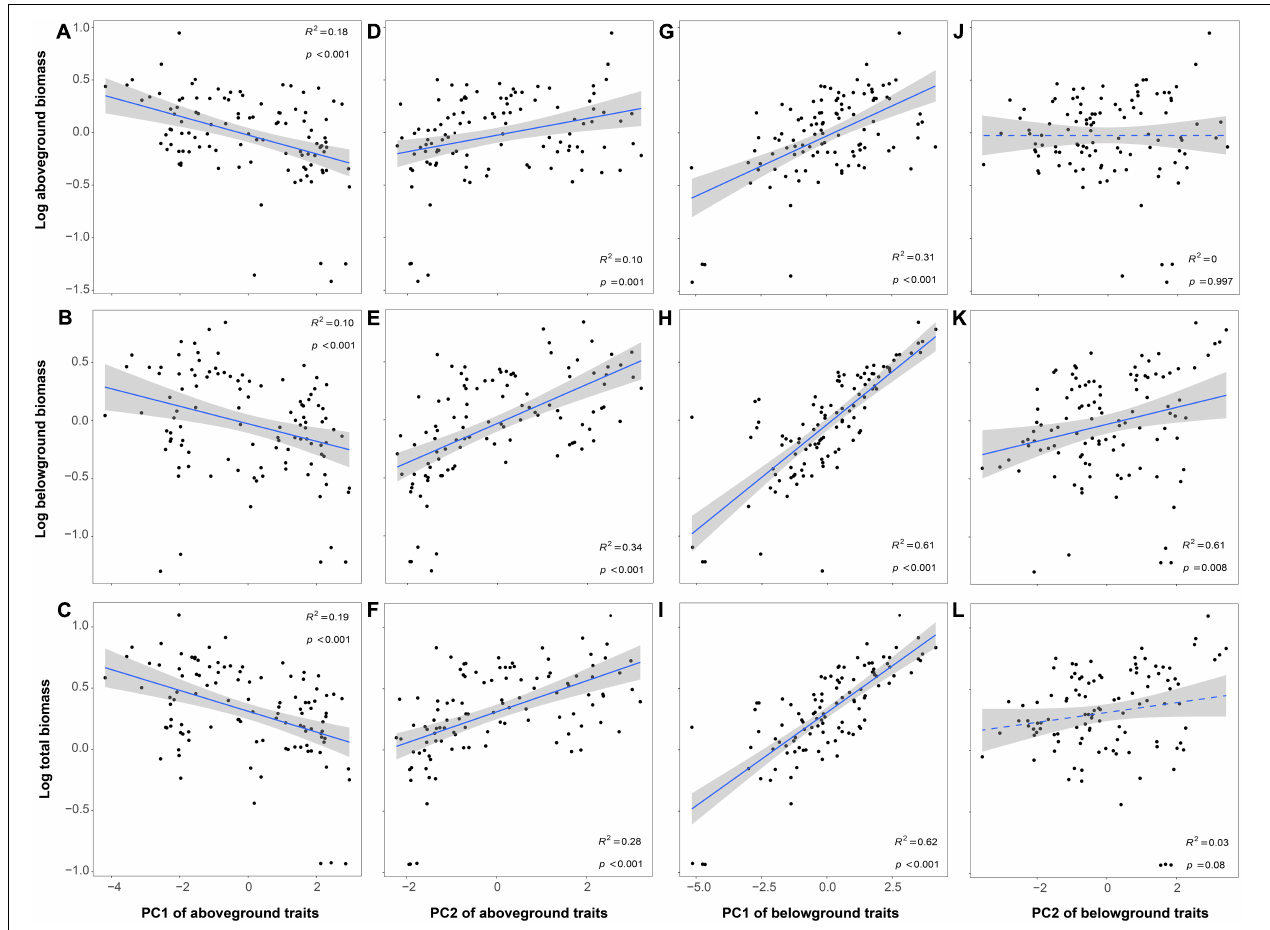
FIGURE 4 | Relationships between plant biomass and plant functional traits [ (A–F) for PC of aboveground and (G–L) for PC of belowground]. The R 2 (coefficient of determination) and p -values are obtained from the linear regression analyses. Shaded areas show 95% confidence interval of the fit